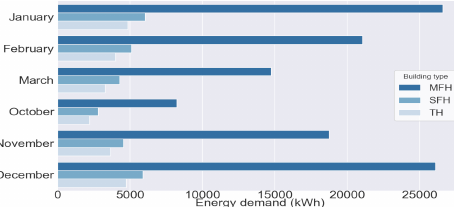
Figure 14. Average monthly energy demand (kWh/month) for each building typology